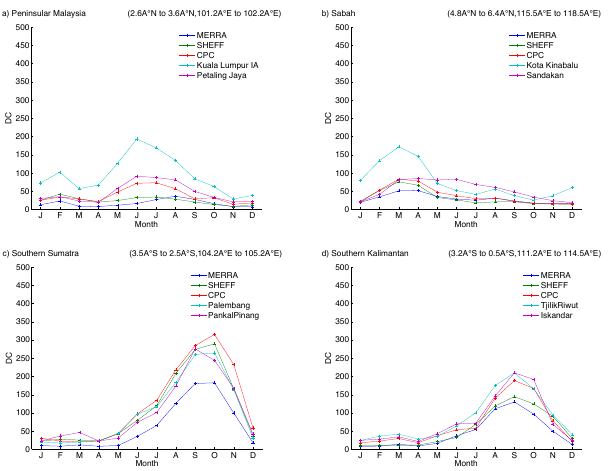
Figure 8. Monthly mean DC for four regions in Australia. MERRA, SHEFF and CPC DC are from the GFWED gridded fields over the latitude and longitude range specified in the caption. The other two DC plots are for representative weather stations in that